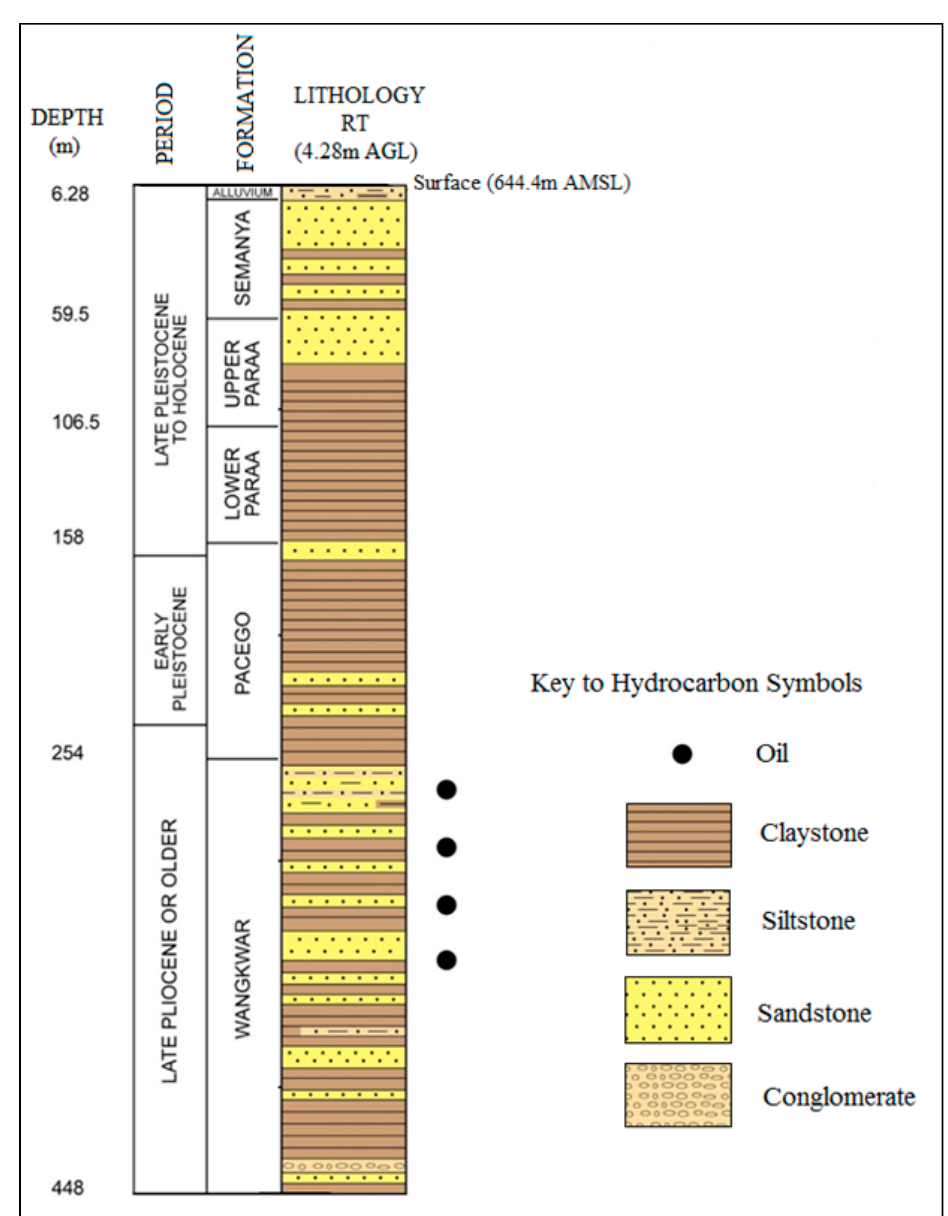
Figure 2. Stratigraphic diagram of the study area.